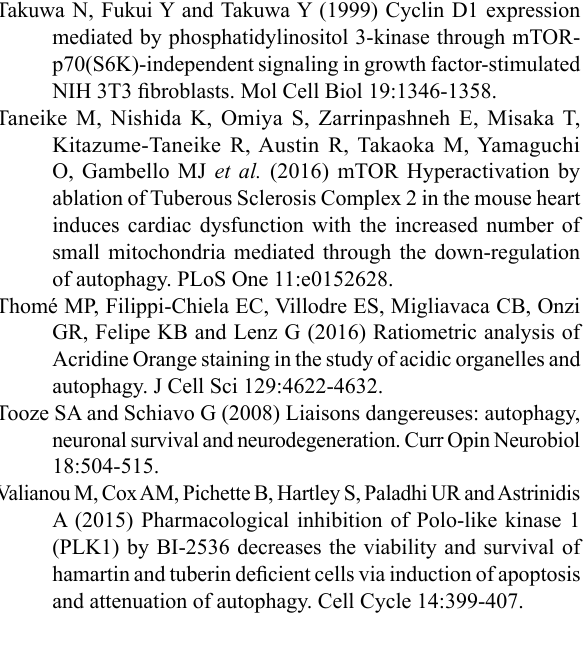
Table S1 ‒ Number of acridine orange positive cells for each condition, patients and